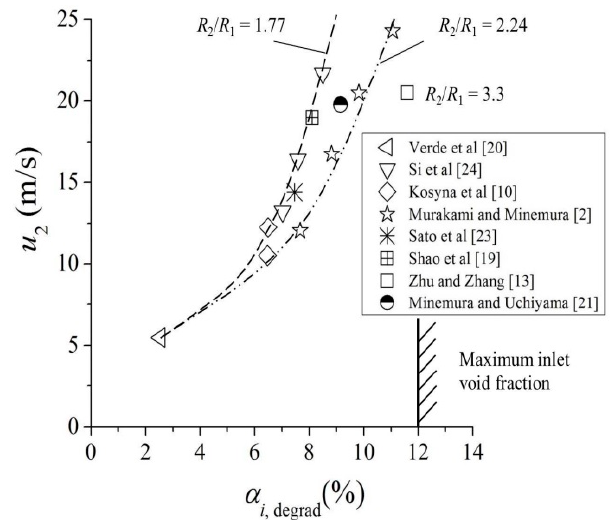
Figure 3. Effects of the impeller outlet rotational speed on the value of α i,degrad .